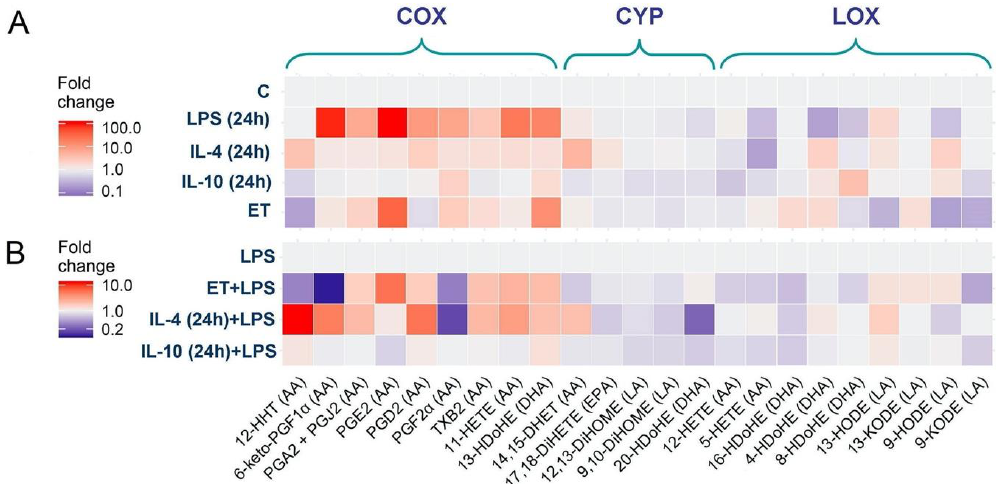
Figure 3. E ff ect of astrocyte polarization on the oxylipins release. A heat map representation of oxylipin production of n-6 and n-3 fatty acid-derived lipid mediators. ( A ) The primary rat astrocytes were treated with IL-4 (10 ng / mL), IL-10 (20 ng / mL), or LPS (100 ng / mL) for 24 h or adapted to endotoxin in the tolerance model (ET). ( B ) Primary rat astrocytes were pretreated with IL-4 (10 ng / mL), IL-10 (20 ng / mL), or adapted to endotoxin (ET, LPS 10 ng / mL for 48 h) and were then stimulated with LPS (100 ng / mL) for 4 h. Concentrations of oxylipins in supernatants were measured using UPLC-MS / MS. The heat map shows relative amounts of each lipid mediator compared to the control. The horizontal axis indicates the stimuli, while the vertical axis indicates the relative amount (log2) of each lipid mediator. Metabolites were divided into: Lipoxygenase (LOX), cyclooxygenase (COX), and cytochrome (CYP) pathways involved in their synthesis.